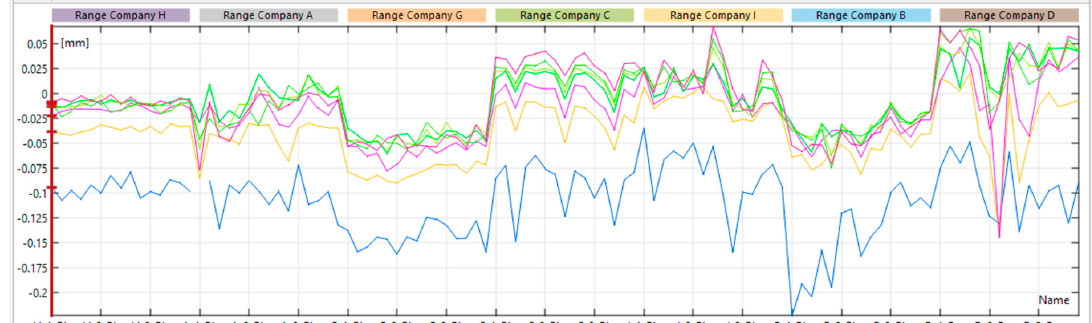
Figure 21. Deviation graph of the hole diameters compared to nominal CAD dimensions produced with GOM Inspect for each hole from each company (in the graph, company F is referred to as company I). Examples of holes are given in Figure 22.